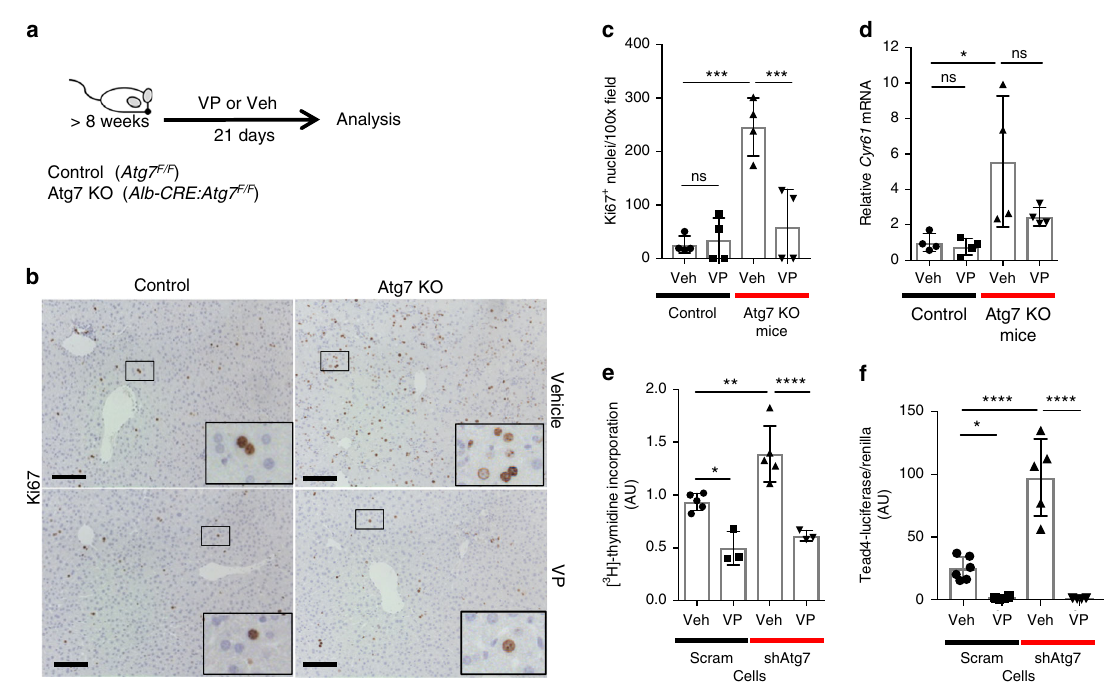
Fig. 5 Yap-dependent proliferation in livers with impaired autophagy is potentially druggable. a Controls ( Atg7 F/F ) and Atg7 KO ( Alb-CRE:Atg7 F/F ) mice were treated for 21 days with either Yap/Tead inhibitor vertepor fi n or vehicle. N = 4 per group. VP, vertepor fi n; Veh, vehicle. b Immunostaining for Ki67 in liver sections from control and Atg7 KO mice treated with either vertepor fi n or vehicle. Scale bar 100 µ m. Large inserts are enlargements of small inserts. c Quantitation of Ki67 + nuclei per 100x fi eld per mouse treated with either vertepor fi n or vehicle. Ten 100x fi elds per mouse were analyzed. d qRT-PCR analysis of whole liver RNA from control and Atg7 KO mice, treated with vertepor fi n or vehicle. Cyr61 mRNA expression was normalized to Gapdh expression and then normalized to control animals. Data from two independent experiments. e [ 3 H]-thymidine incorporation assay in scram- and shAtg7- AML12 cells after incubation with vertepor fi n or vehicle. Data from three independent experiments, measurements in triplicates. **** P = 0.0003. f Tead4- Luciferase assay of scram- and shAtg7-infected AML12 cells after incubation with vertepor fi n or vehicle. Data from two independent experiments Data represent mean ± SD. P -values analyzed by two-way ANOVA and Tukey ’ s HSD. * P < 0.05, ** P < 0.01, *** P < 0.001, **** P < 0.0001 unless indicated otherwise. ns, not signi fi cant; VP, vertepor fi n; Veh,